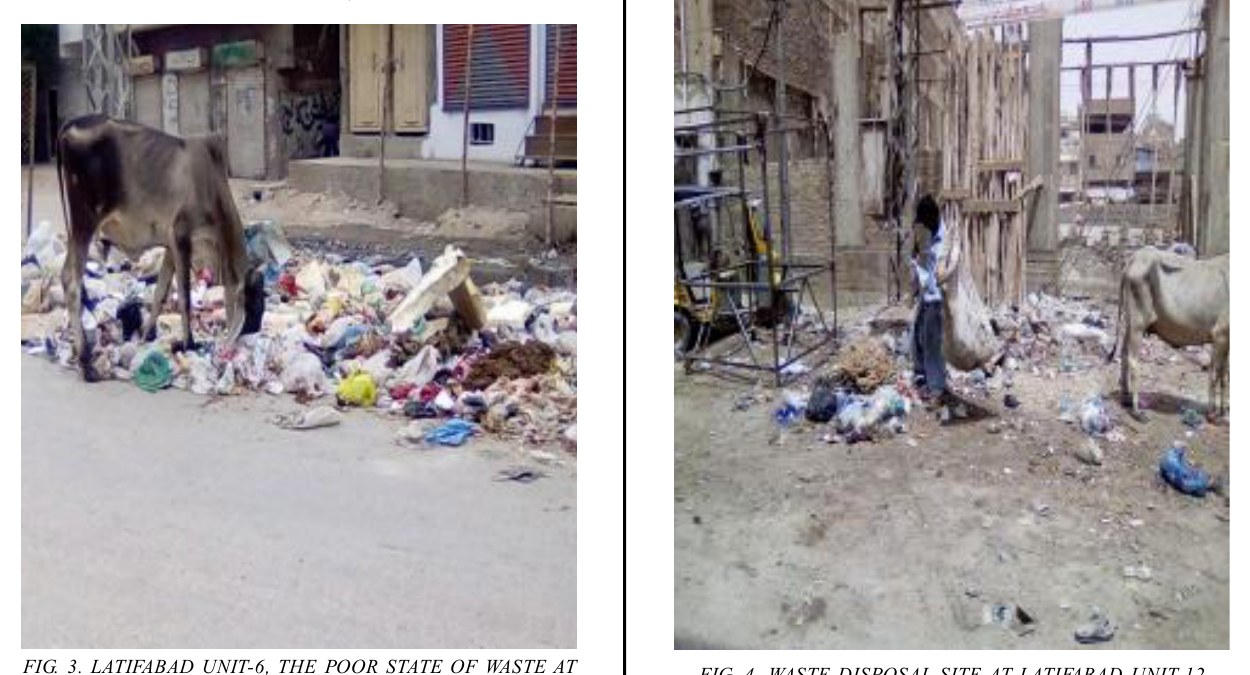
FIG. 4. WASTE DISPOSAL SITE AT LATIFABAD UNIT-12